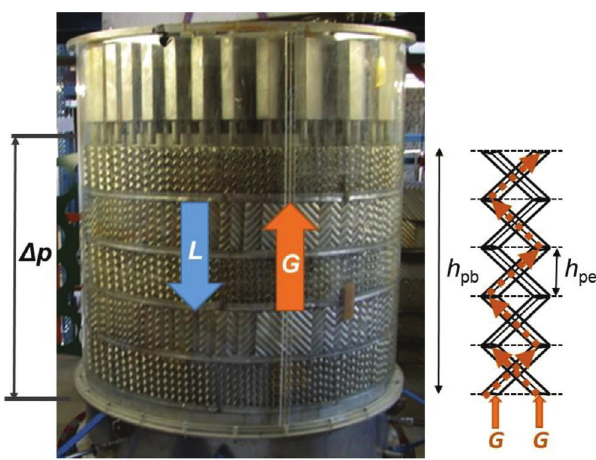
Fig. 3 – Photograph of a packed bed consisting of five layers of corrugated sheet structured packing Montz-pak B1-250, and a sketch illustrating basic flow channel structure forcing the pres sure-driven ascending gas or vapor to follow a zigzag flow path